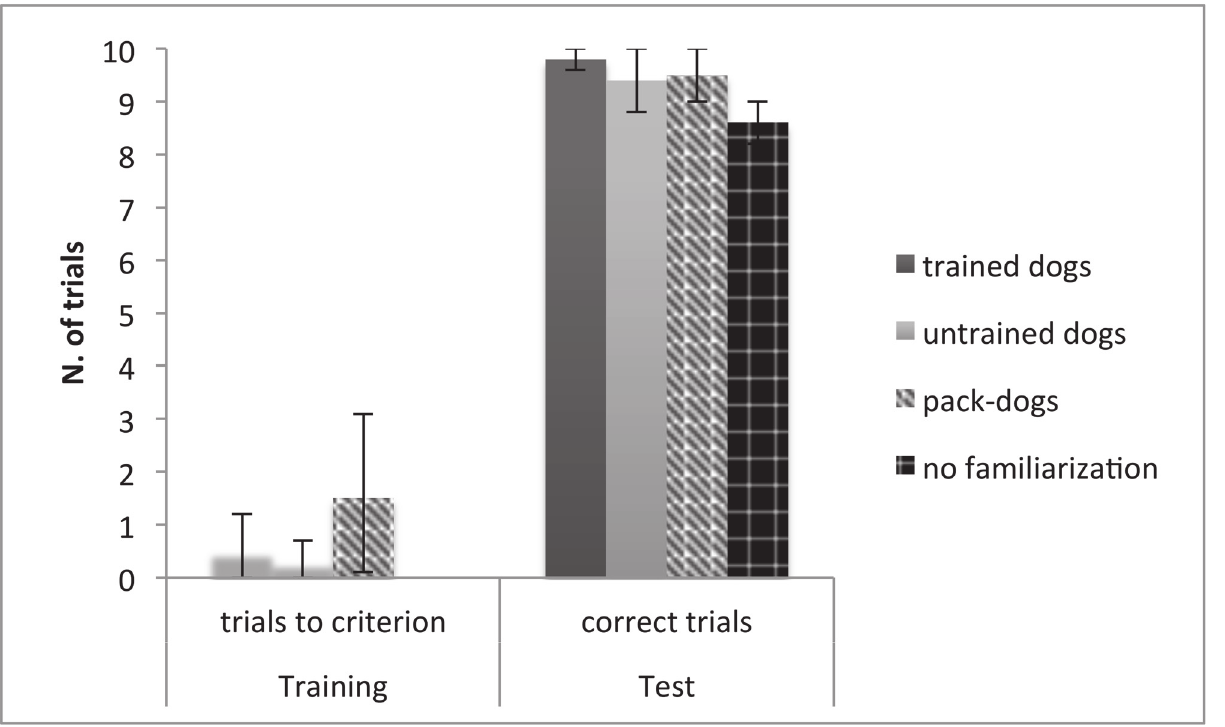
Fig 4. Pet- and pack- dog ’ s performance in the cylinder task. Mean number (and 95% confidence interval) of trials to criterion in the training phase, and of correct trials in the test phase, for trained and untrained pet dogs and dogs tested with no prior familiarization with the opaque